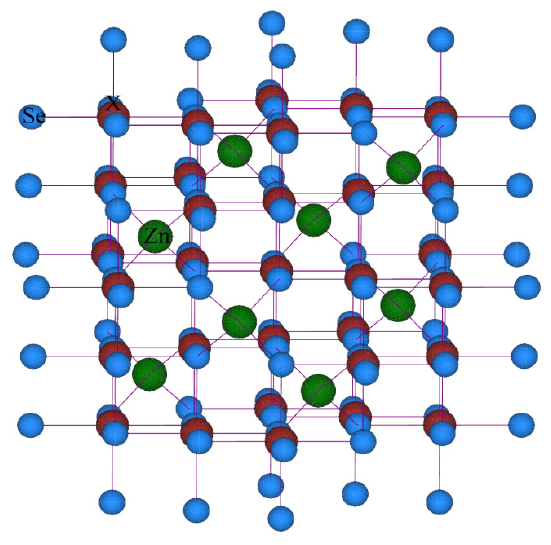
Figure 1. The crystal structure of ZnX 2 Se 4 (X = Ti, V, Cr) formed by VESTA Software . Table 1. The computed a(Å): Lattice constant, B(GPa): Bulk modulus, E coh : Cohesive energy, Δ H f (eV): Formation energy and T c (K): Curie temperature of ZnX 2 Se 4 (X = Ti, V,